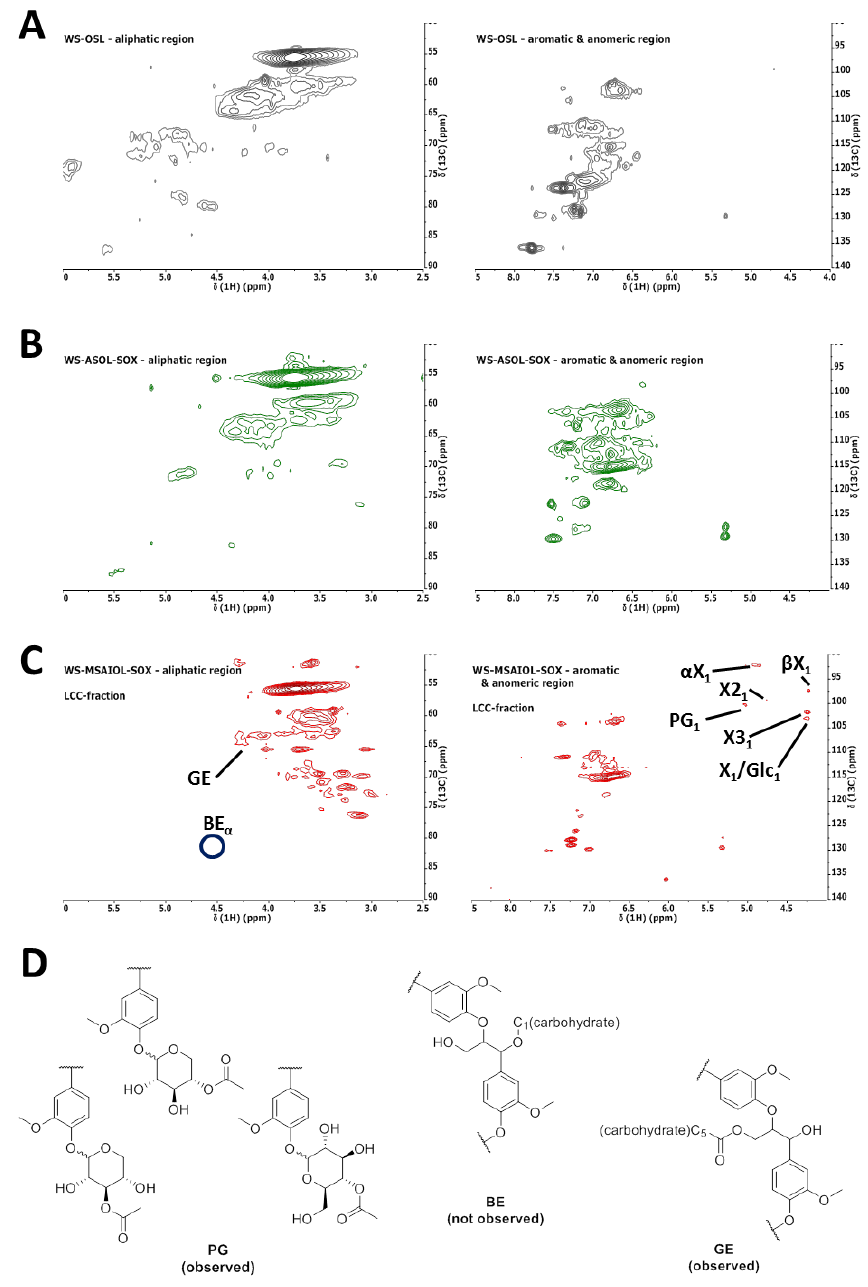
Figure 6. 1 H– 13 C HSQC spectra obtained for: ( A ) WS-OSL [9]; ( B ) WS-ASOL-SOX ; and ( C ) WS-MSAIOL-SOX (PG 1 , phenyl glycoside (linkages); αX 1 , (1 → 4)-α- D -xylopyranoside; βX 1 , (1 → 4)-β- D -xylopyranoside; X3 1 , 3- O -acetyl-β- D -xylopyranoside; X 1 /Glc 1 , β-d-xylopyranoside/β- D -glucopyranoside). ( D ) Structural representation of postulated LCC motifs ( PG , phenyl glycoside; BE , benzyl ether; GE , γ-ester). Assignments in ( C ) are based on earlier reports [13,25,26]. Circles in ( C ) indicate positions of cross peaks that would be indicative of benzyl ether-type LCC-structures, indicated as “not observed” in ( D ).